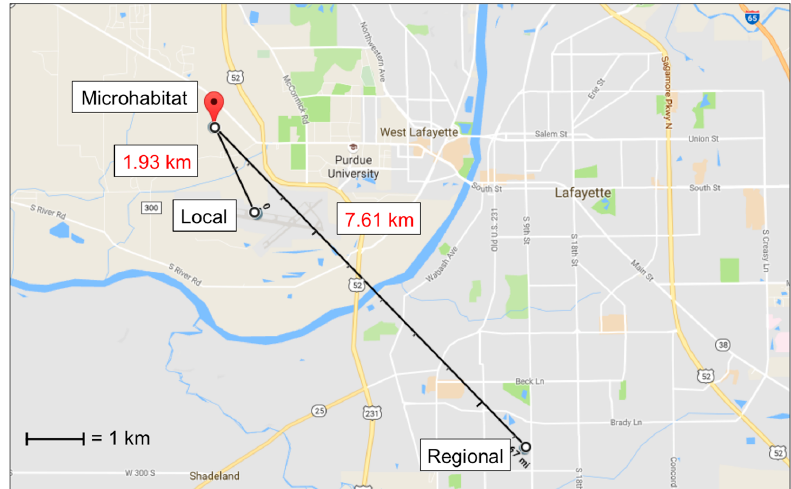
Figure 1. Map showing the location of and distances between the microhabitat (HOBO temperature loggers), local (Purdue University Airport weather station), and regional (Lafayette weather station) temperature sources. The microhabitat was the average of temperatures measured at each of the six carcasses. (Map: Google, Google).